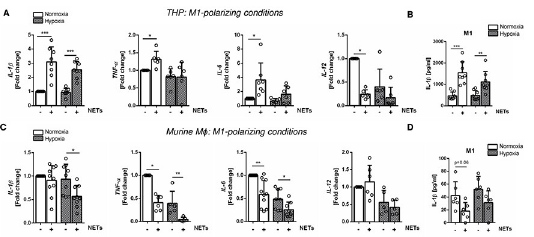
Fig 2. Impact of NETs on the expression of pro-inflammatory cytokines by human and murine macrophages. THP-1-derived macrophages and murine bone marrow-derived macrophages were cultured in the presence of LPS + IFN- γ and human or murine NETs (1000 ng/ml), respectively, for 24 h. In parallel experiments, cells were cultured under hypoxic conditions (2% oxygen). Expression levels of IL-1 β , TNF- α , IL-6 and IL-12 as well as IL-1 β protein secretion were analyzed by Real-time PCR and Elisa in human THP-M1 (A, B; n = 6–8) and murine M1 (C, D; n = 5–10) macrophages. � P < 0.05, �� P < 0.01, ��� P < 0.001 (Unpaired t test, Mann-Whitney test, One-sample t test, Wilcoxon signed-rank